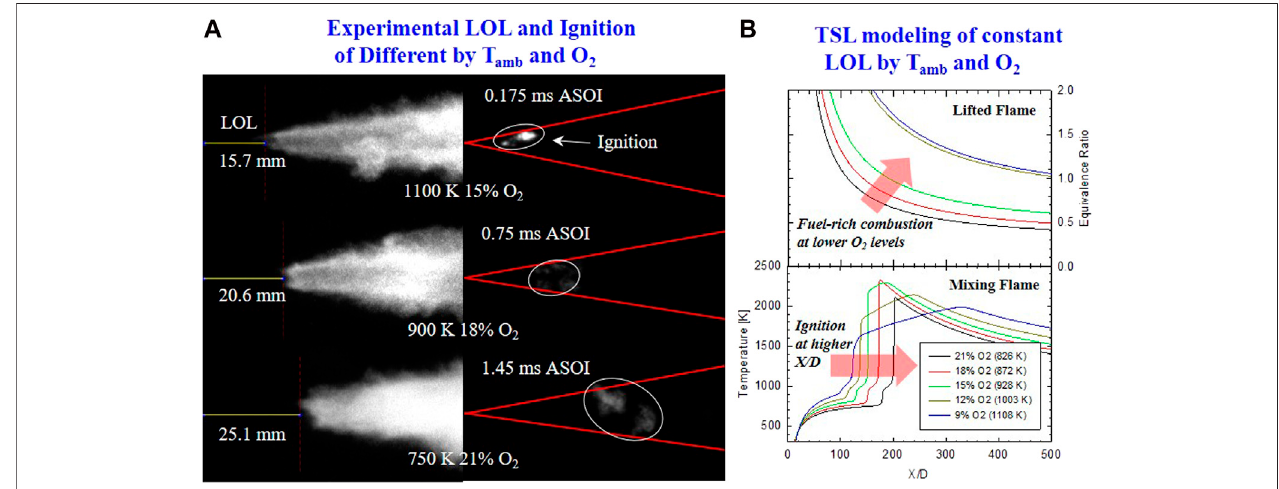
FIGURE8|(A) Time-averagedOH*chemiluminescence (left) and InstantaneousHScombustion luminosity (right) ofinitial ignition.ConditionsofT amb and O 2 are given in each row. Same P inj of 75 MPa, and ρ amb of 14.8 kg/m 3 (B) TSL simulation results of ϕ (top) from lifted fl ame along spray axis, and spray core temperature (bottom) from mixing model. LOL is fi xed by a different combination of T amb and O 2 . Other conditions are similar with P inj (cid:1) 75 MPa, ρ amb (cid:1) 14.8 kg/m 3 .